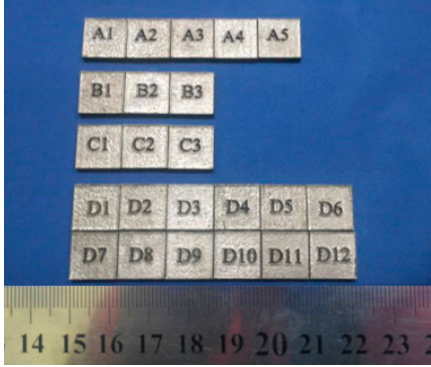
Figure 3. The CoCr alloy metallographic samples produced by different processes using SLM.